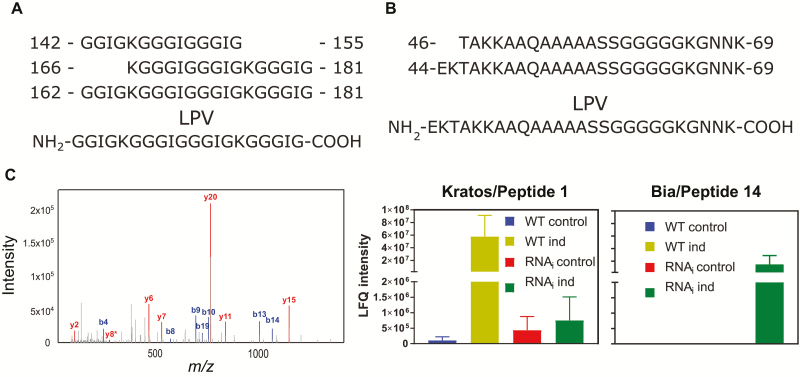
METACASPASE9-dependent accumulation of the peptides Kratos and Bia. (A) The assembly of the longest peptide variant (LPV) from the extracellular peptides matching the glycine-rich peptide Kratos/Peptide1 derived from the unknown protein AT3G23450 (Supplementary Table S1). (B) The assembly of the LPV from the extracellular peptides matching the small EDRK-rich factor (SERF) peptide Bia/Peptide 14 derived from the uncharacterized protein AT3G24100 (Supplementary Table S1). (C) Illustration of mass spectrometry identification of the longest identified peptide in (A) and charts displaying quantifications of the average label free quantification (LFQ) intensity for the LPV Kratos/Peptide 1 and Bia/Peptide 14 in the different genotypes and conditions. Error bars represent standard error of the mean (n=3 biological replicates).